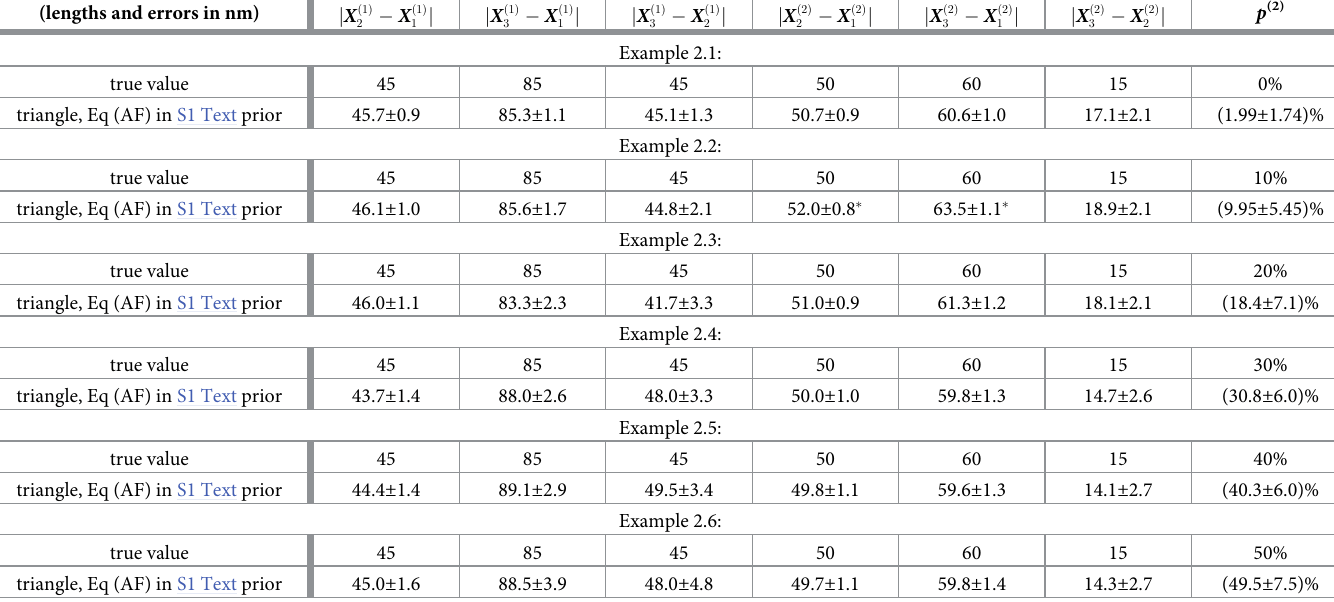
Table 2. Two-state simulated examples (anisotropic measurement error).